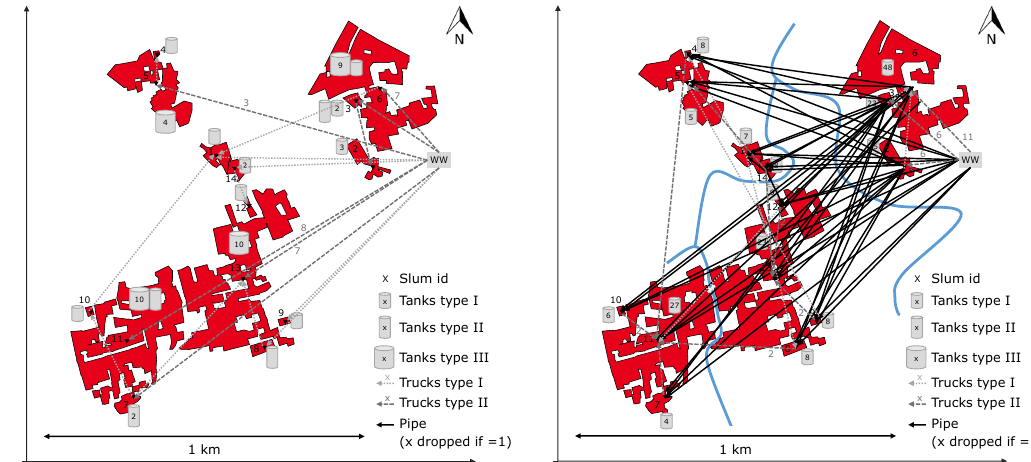
Figure 14. Optimization result for a slum cluster in Dhaka 2010, Bangladesh, with 14 slums (left) and with additional consideration of geographic barriers